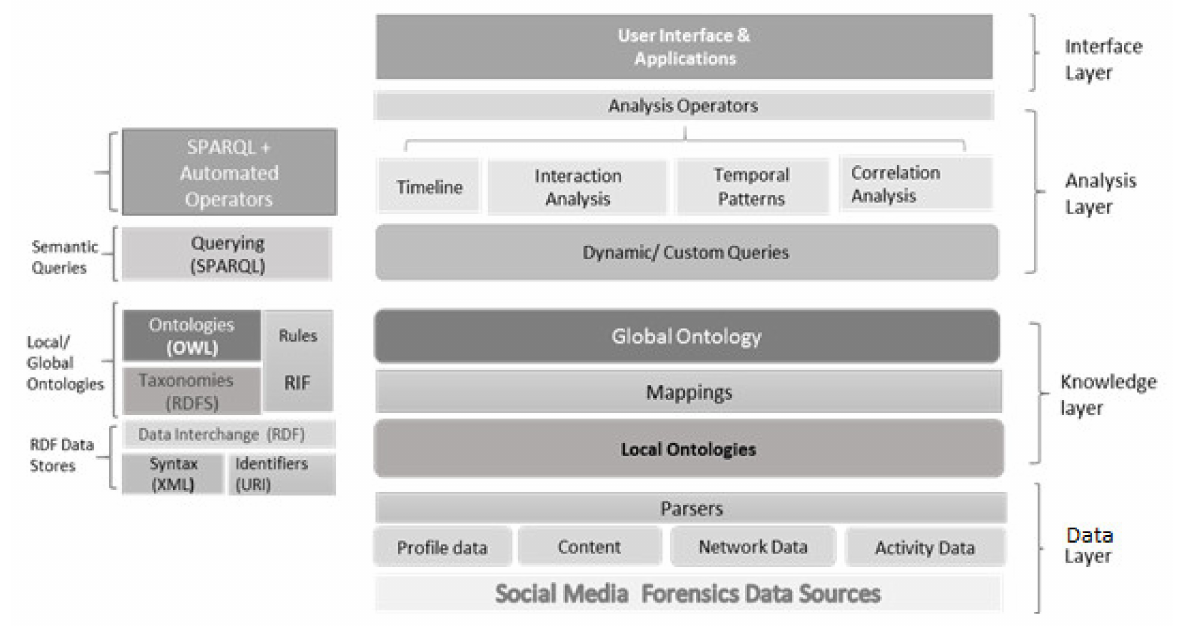
Figure 3. Implementation details of the multi-layered